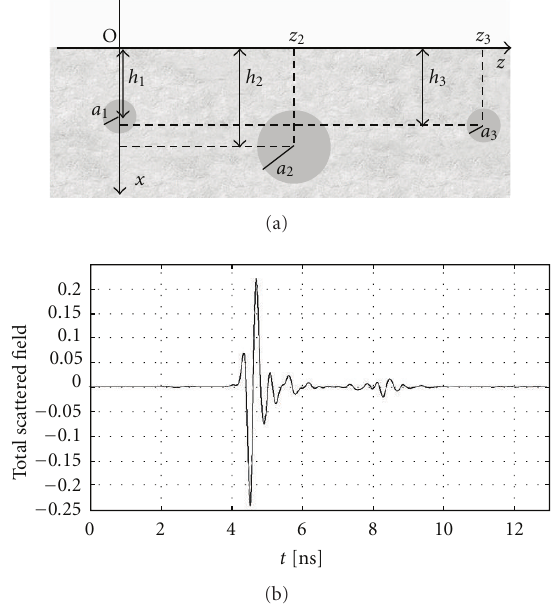
Figure 10: Time-domain results for three buried metallic